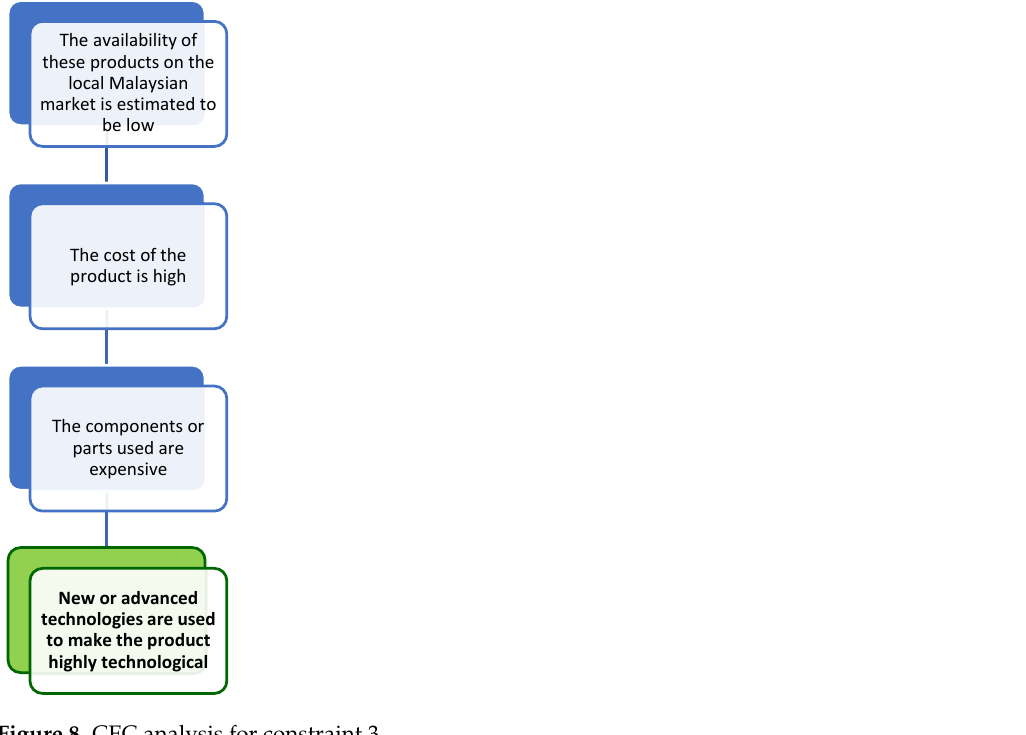
Table 11. System parameters for technical contradiction (constraint 3).